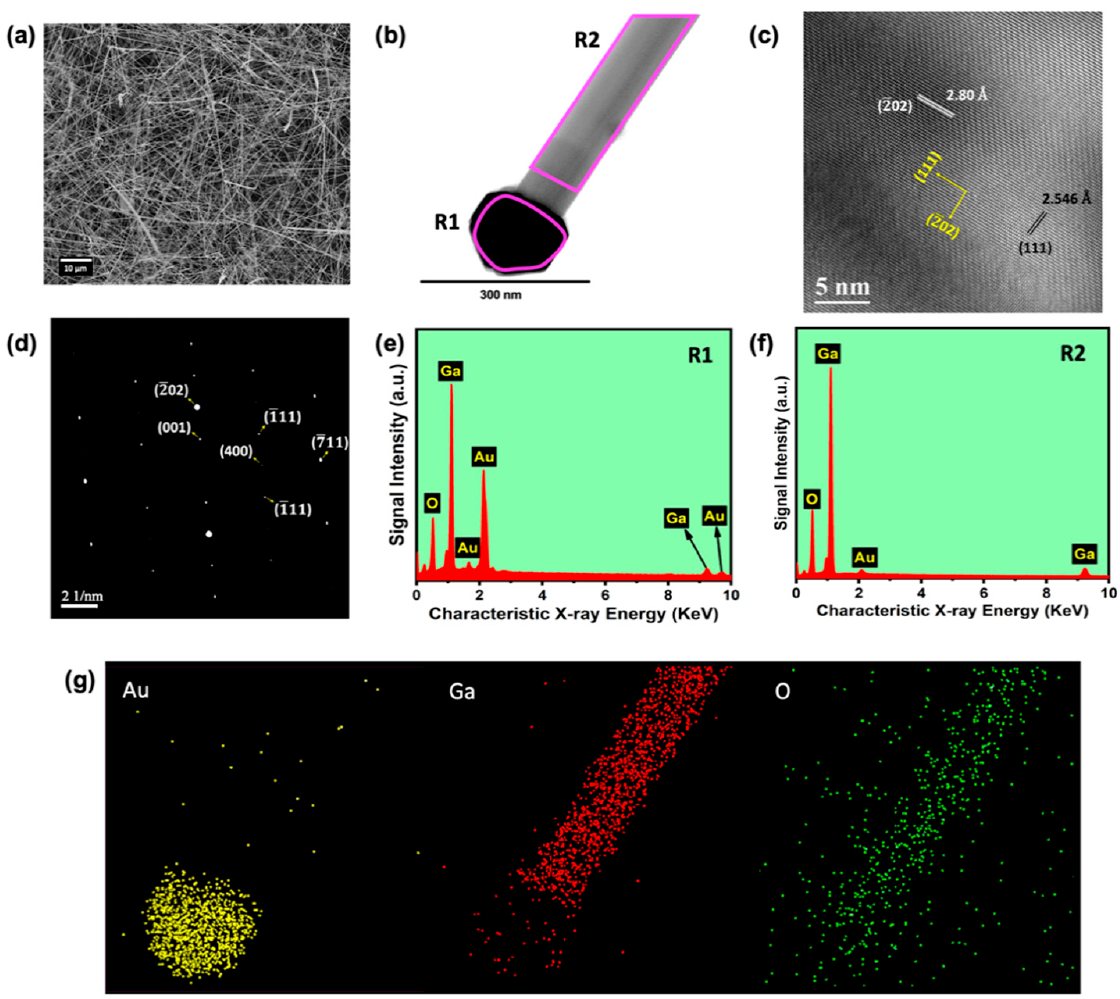
Figure 3. ( a ) SEM image of 1D β -Ga 2 O 3 nanowires on Si (100) substrate, ( b ) TEM image of a single nanowire and Au catalyst nanoparticle on top of a single β -Ga 2 O 3 nanowire, ( c ) HR-TEM image showing the crystal lattices, ( d ) SAED pattern of a single nanowire, ( e ) elemental mapping of individual Au, Ga, and O elements corresponding to the TEM image of a single β -Ga 2 O 3 nanowire shown in ( b ), ( f ) EDS spectrum recorded at the marked regions R1 and R2 in the single nanowire shown ( g ).